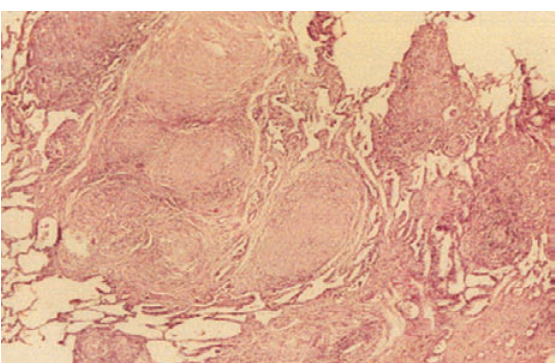
Figure 3. Multiple granulomas composed of epithelioid histiocytes surrounded by lymphocytes and Langhans type giant cells, and emphysematous changes in the peripheral